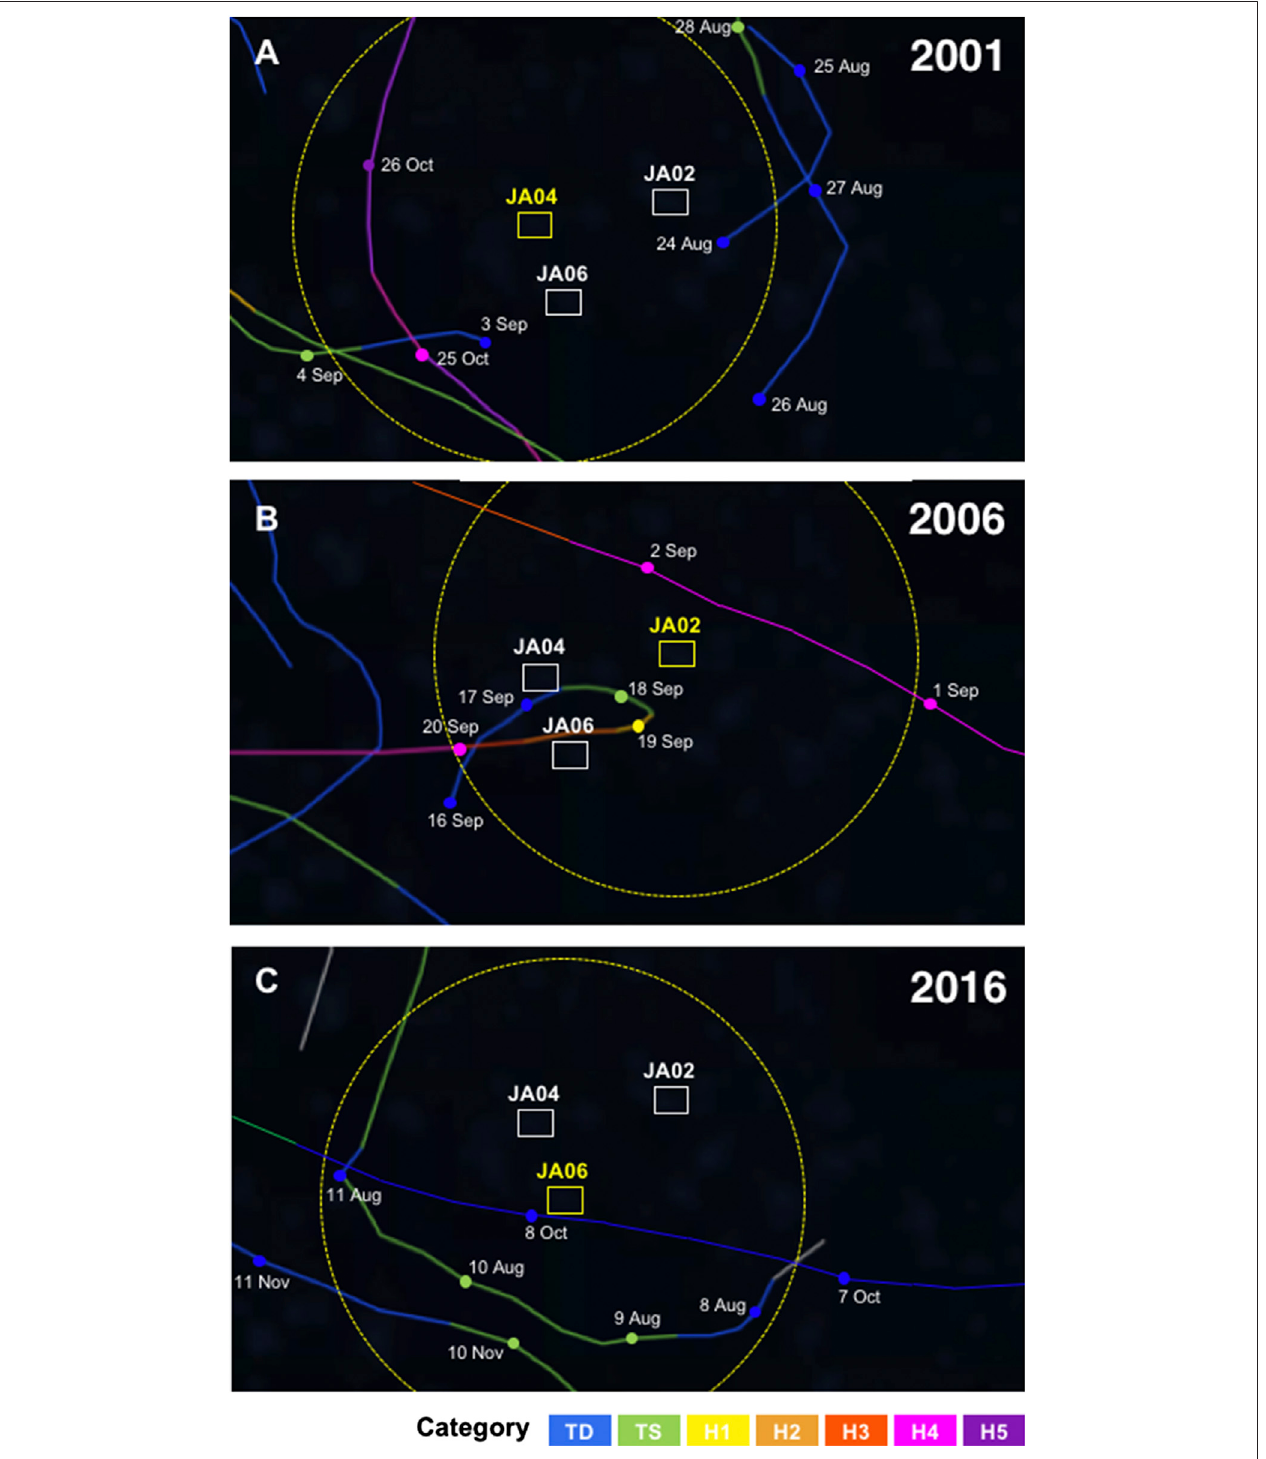
FIGURE 6 | Tracks of hurricanes (typhoons) passing through Japan ’ s exploration area in (A) 2001 (B) 2006, and (C) 2016. Data are from NOAA ’ s historical hurricane tracks (https://coast.noaa.gov/hurricanes/). TD: tropical depression, TS: tropical storm, H1 – H5: hurricanes of category 1 – 5 on the Saf fi r – Simpson scale. For each year, the seamount where sediment trap observations were conducted is highlighted in yellow. Yellow dashed-line circle indicates radius 500 km from the highlighted seamount.